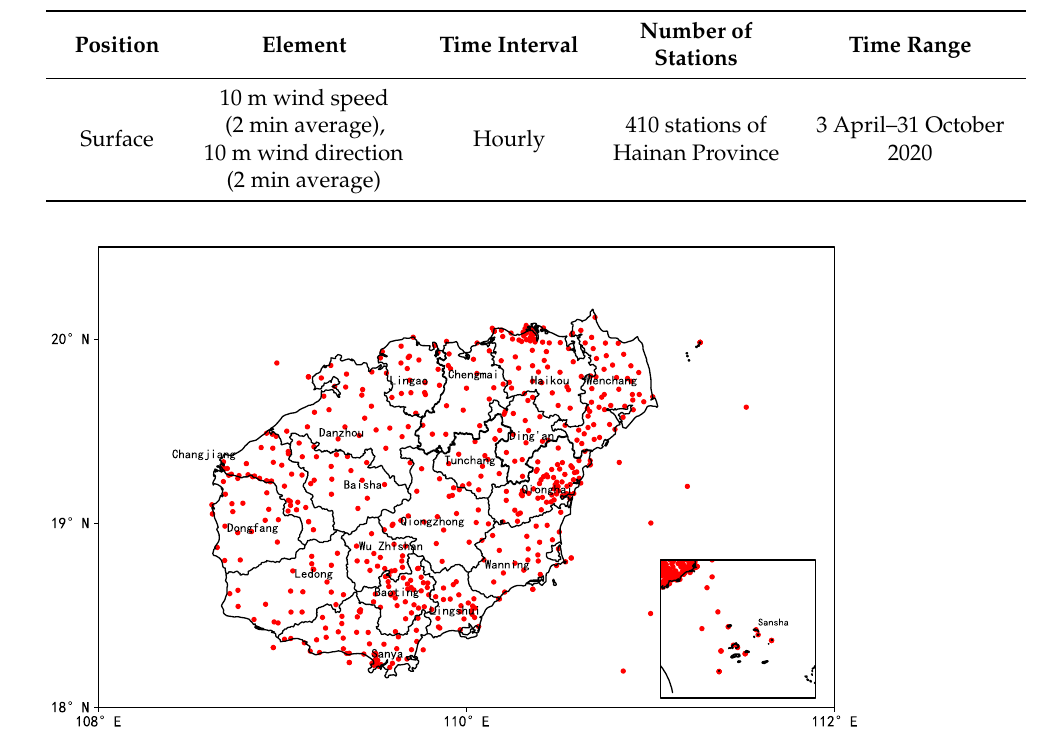
Table 1. Information on surface meteorological observation data.